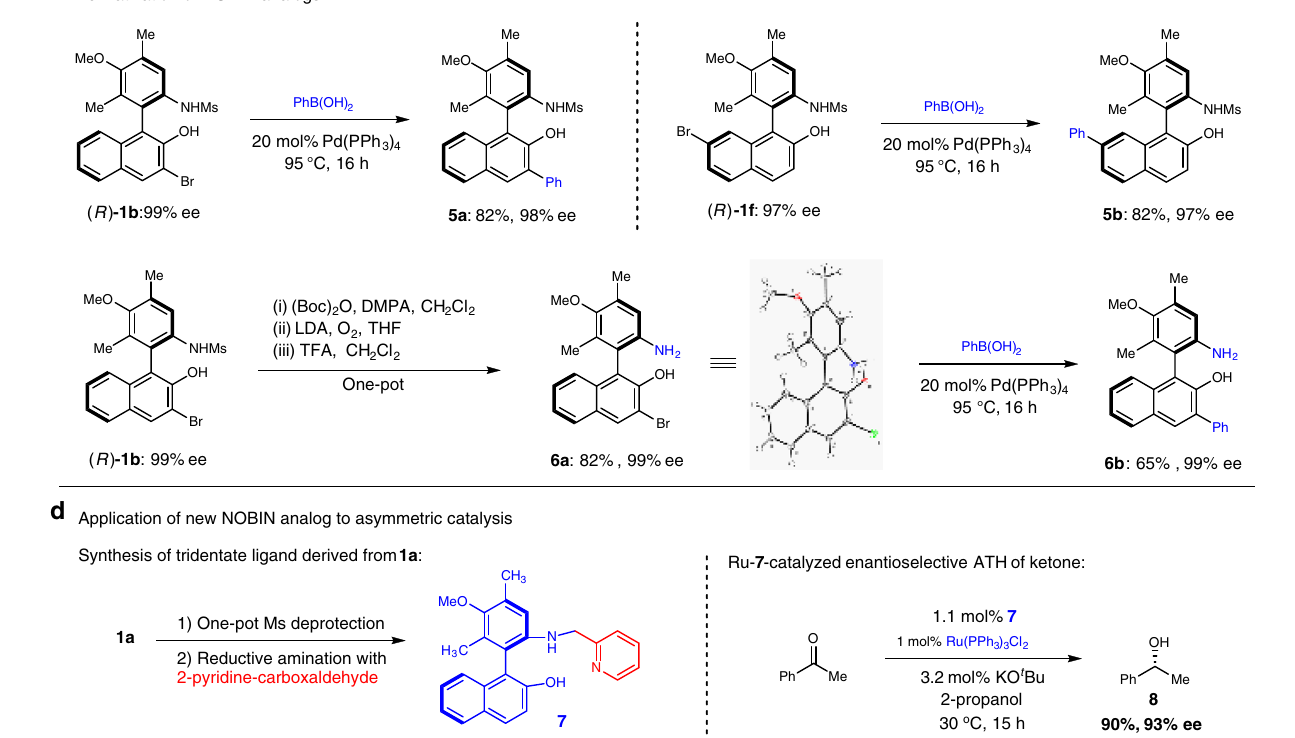
Ru- 7 -catalyzed enantioselective ATH of ketone:Synthesis of tridentate ligand derived from 1a :